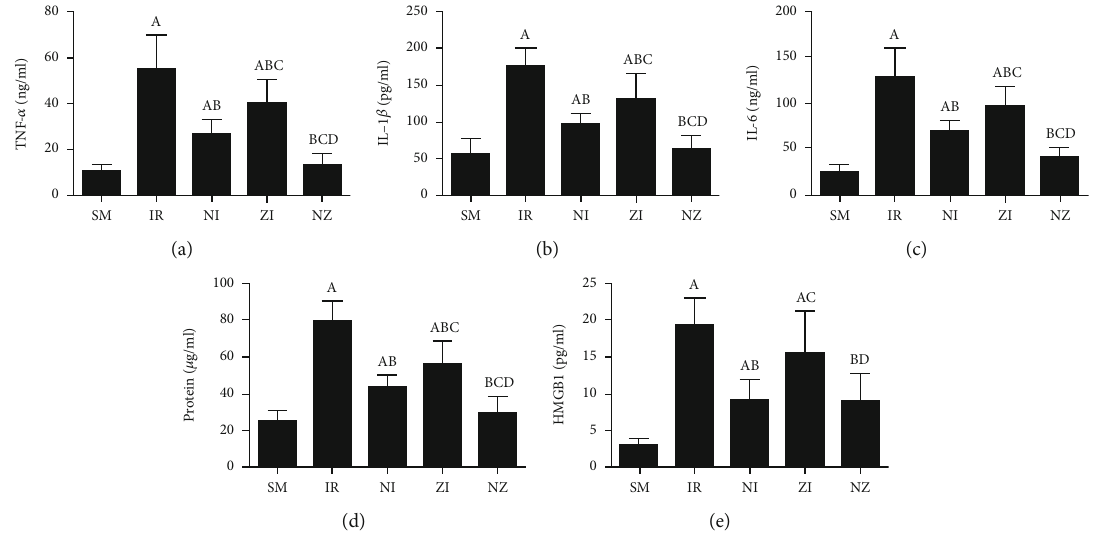
Figure 6: In fl ammatory markers and protein concentration in the BAL fl uid. The rats were randomly divided into fi ve groups. Brie fl y, the rats in the SM group received sham operation, while the left lung hilum was subjected to 1 h of ischemia followed by reperfusion up to 3 h in the IR group. Intraperitoneal Nec-1 (1 mg/kg) and z-VAD-fmk (3 mg/kg) were administrated before lung ischemia in NI and ZI groups, respectively, and combined administration of Nec-1 and z-VAD-fmk was given in the NZ group. After 3h of reperfusion, the BAL fl uid was harvested, and the levels of TNF- α , IL-1 β , IL-6, protein, and HMGB1 in the BAL fl uid were detected. BAL fl uid: bronchoalveolar lavage fl uid; TNF- α : tumor necrosis factor- α ; IL-1 β : interleukin-1 β ; IL-6: interleukin-6; HMGB1: high-mobility group box 1. Data were presented as mean ± SD , n = 8 in each group. a P < 0 : 05 compared with the SM group, b P < 0 : 05 compared with the IR group, c P < 0 : 05 compared with the NI group, d P < 0 : 05 compared with the ZI